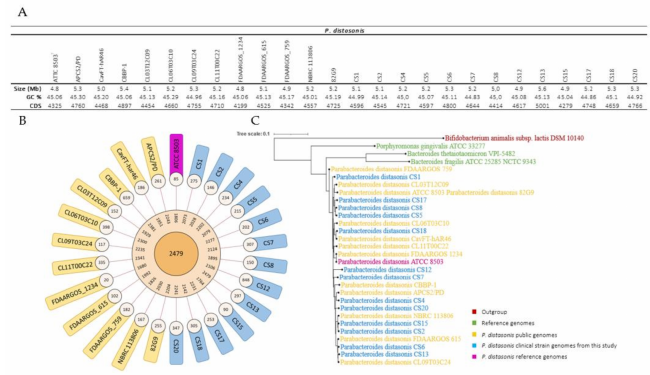
Figure 1. P. distasonis genomes characterization. ( A ) General features of P. distasonis genomes used in this study. ( B ) Graphical representations of the pangenome characteristics. From the center outward: core, dispensable and specific genome. ( C ) Phylogenetic analysis of 26 strains of P. distasonis . B. thetaiotaomicron VPI-5482 T [39], P. gingivalis ATCC 33277 T [40] and B. fragilis ATCC 25285 T